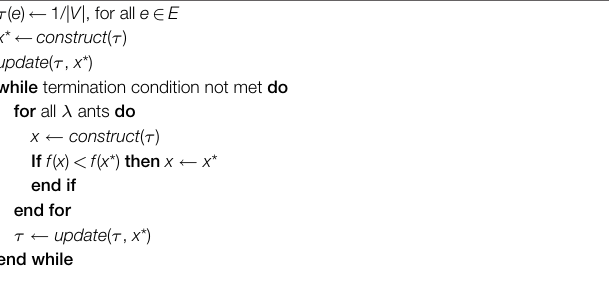
ALGORITHM 1 | Outline of Ant Colony Optimization